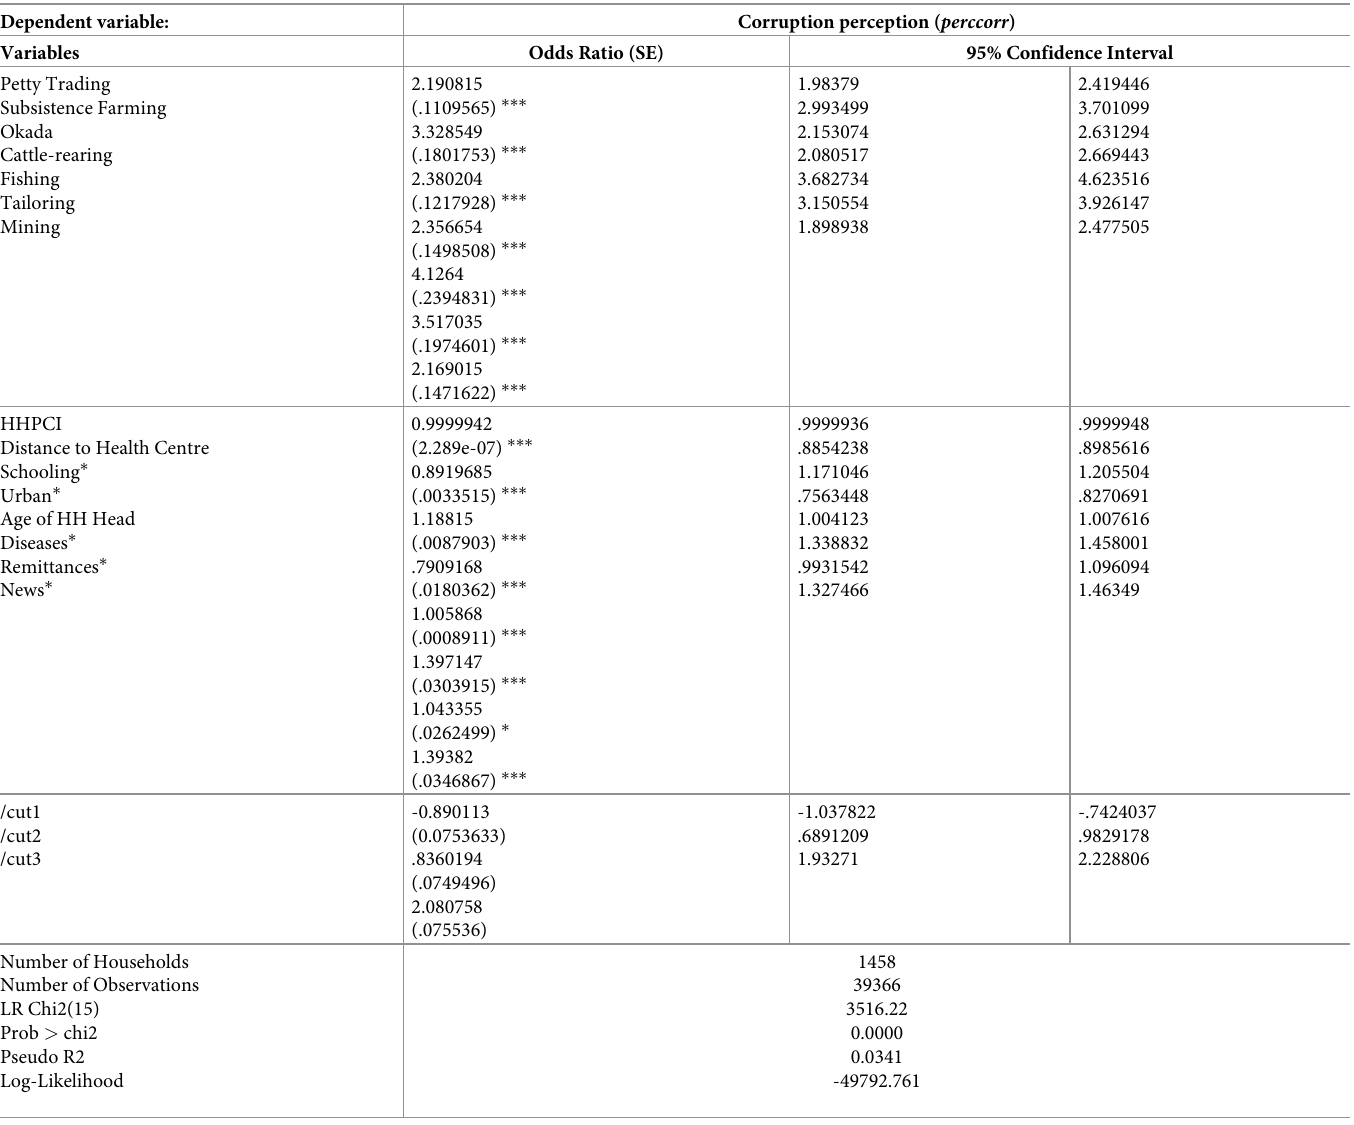
Table 5. Relationship between perceived corruption and household characteristics—ordered